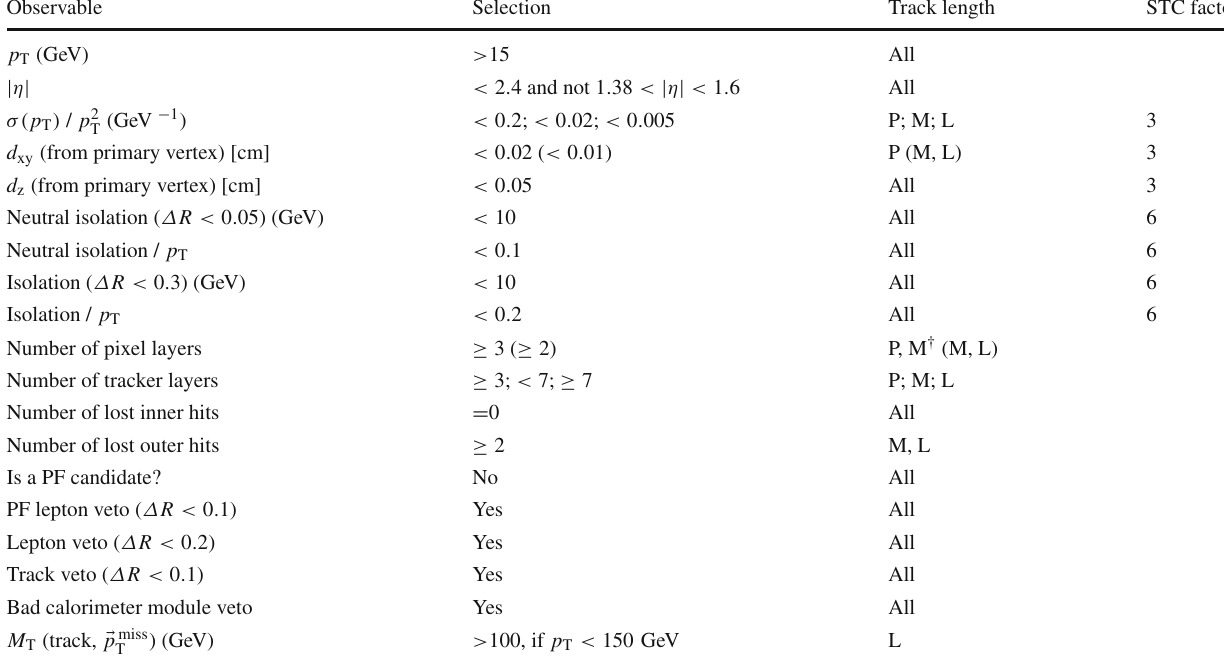
or not. The selected tracks are as well required to not be identified as PF candidates, and to not overlap with other tracks with p T > 15 GeV, even if those tracks are not associated with PF candidates. The factor by which the selection requirement is relaxed in order to select short track candidates is also reported. If no factor is reported, the requirement is not relaxed for the selection of short track candidates